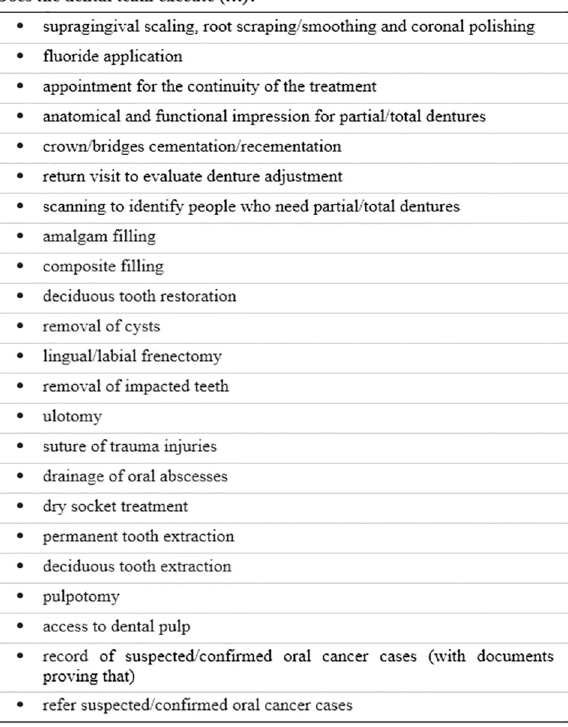
Fig 1. Questions related to the dental procedure’s execution asked to the PHC dentist in a face-to-face interview.